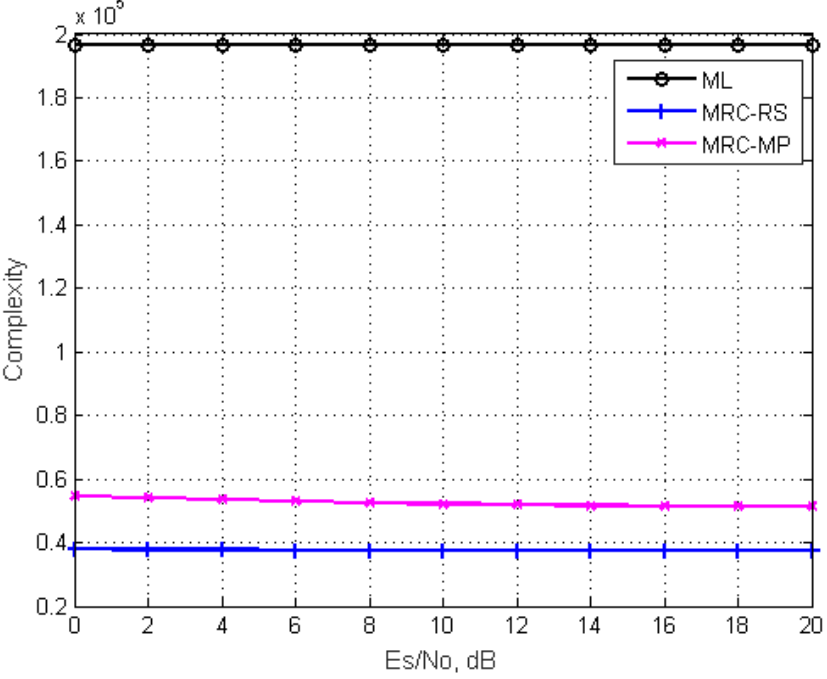
Figure 6. Comparison of the computational complexity of the proposed detectors and ML detectors for a GSM system with N t = 32, N r = 16, M = 8 and N p =